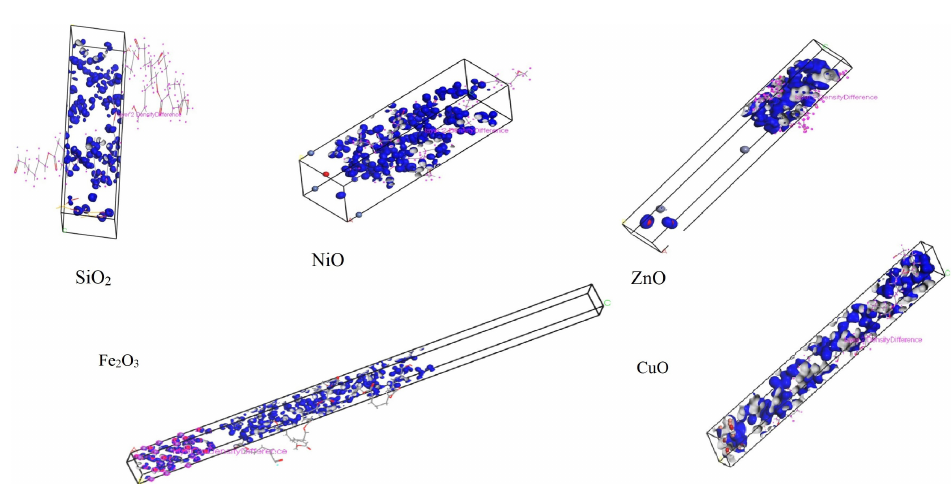
Figure 3. Charge density differnce plots of metal oxides(unit cell)/PCL